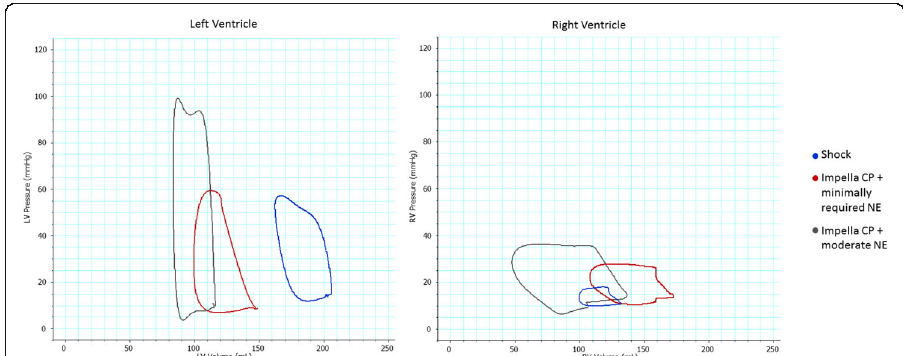
Table 3 Cardiac work in RV and LV during CS and mechanical support RV SW, mmHg × mL, median (Q1, Q3) RV PE, mmHg × mL, mean (SD) RV PVA × HR*10 3 , mmHg/min, mean (SD) LV SW, mmHg × mL, mean (SD)